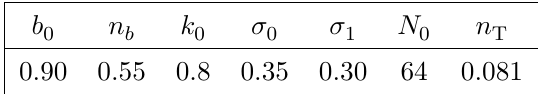
Table 2 . Values of the (cid:12)t parameters from eqs. (A.3) and (A.4), describing the cluster contribution in the data OS correlation function. The estimated uncertainty in the parameters is about